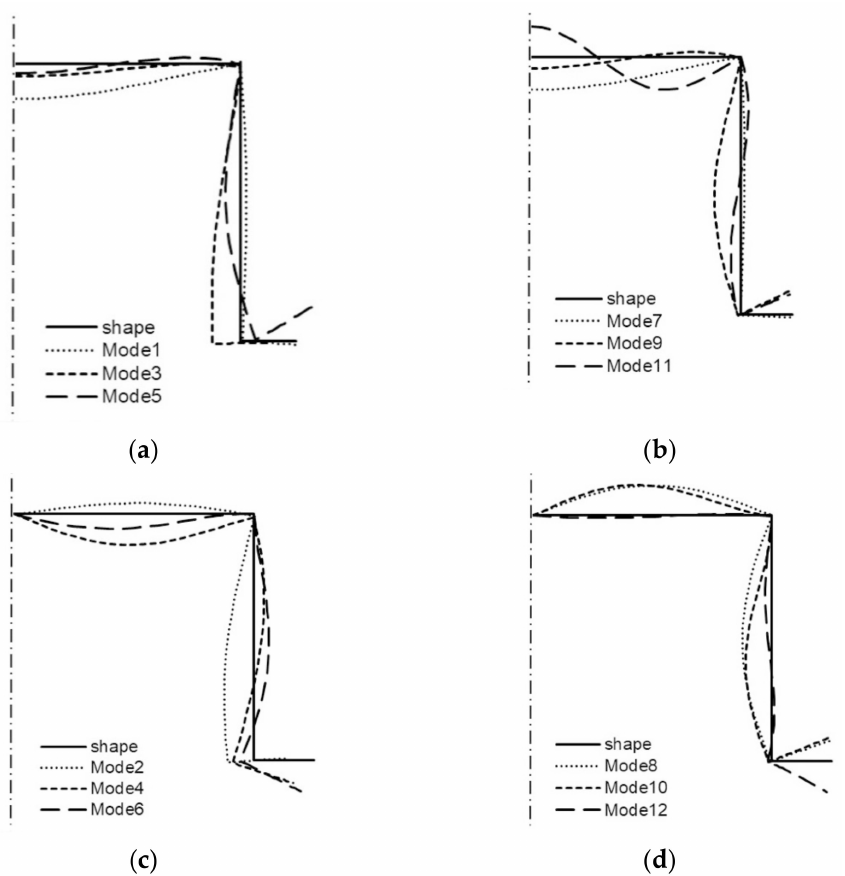
Figure 15. Buckling modes of the TH-channel of total length 130 mm (Table 3): symmetrical modes 1, 3, 5 ( a ), modes 7, 9, 11 ( b ), and anti-symmetrical modes 2, 4, 6 ( c ), modes 8, 10, 12 ( d